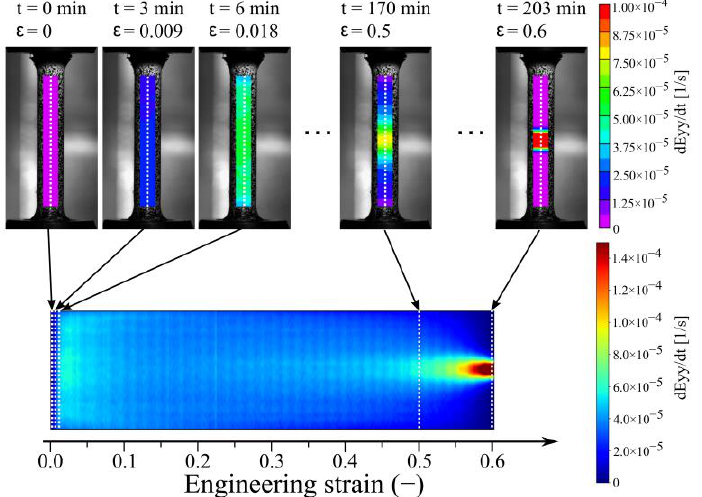
Figure 3. Illustration of data extraction procedure for strain rate maps. Strain rate values are interpolated and extracted at 200 equidistant points along the central line in the loading direction on the sample surface (dotted lines) on each of the individual time frames. The extracted strain rate values for each timeframe are subsequently plotted in a color map, horizontally next to each other, as a function of time or, equivalently, in a displacement-controlled test, engineering strain.